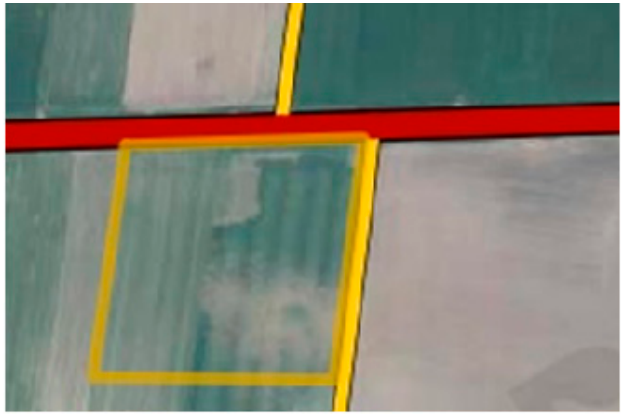
Figure 1. Selected location—plot No. 189 in the village of Ł uby-Kurki (V3). Source: